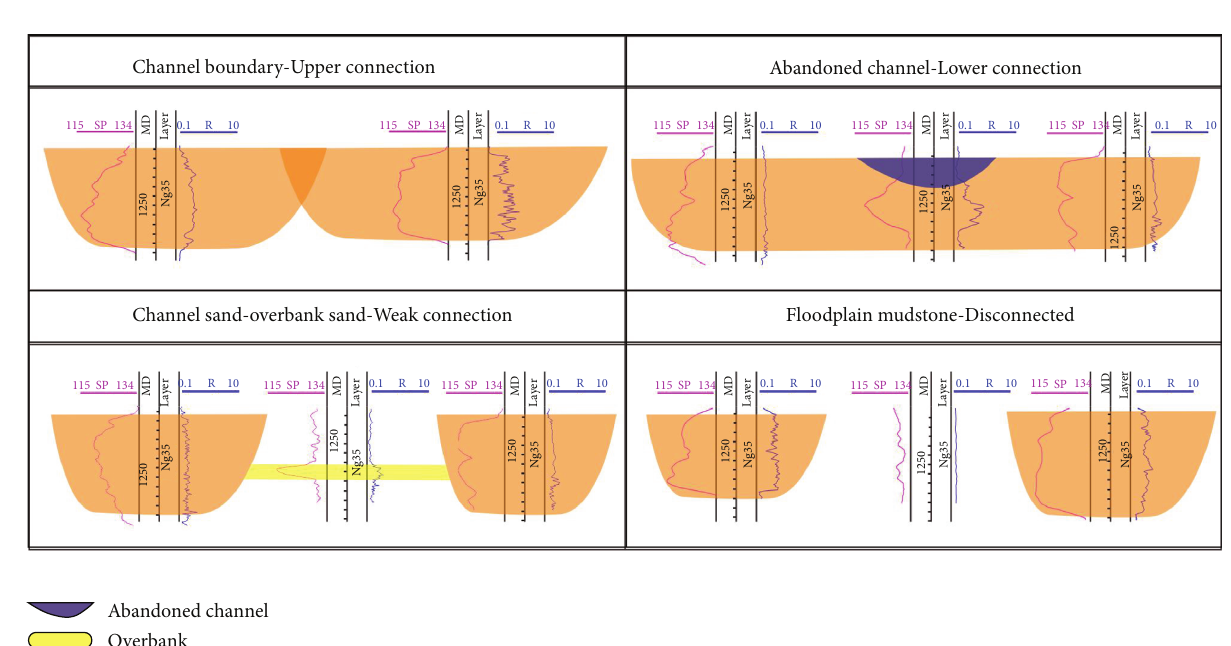
Figure 1: Types of interlayer seepage barriers.